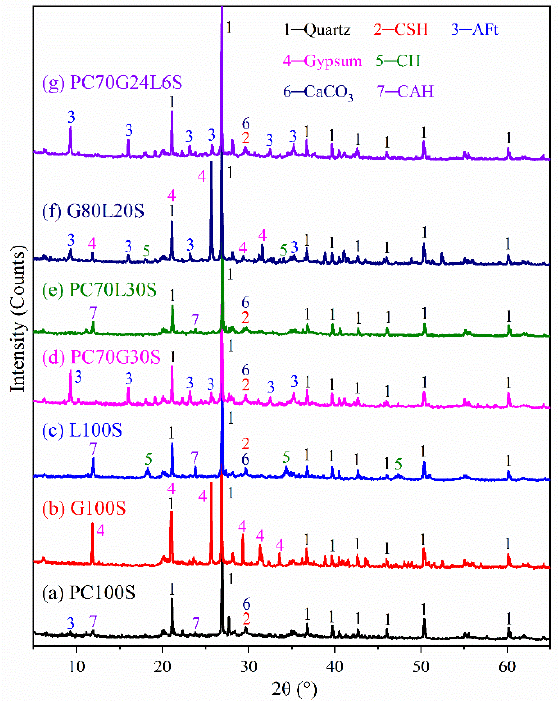
Figure 4. X-ray diffraction (XRD) diffraction patterns of the stabilized soil samples.